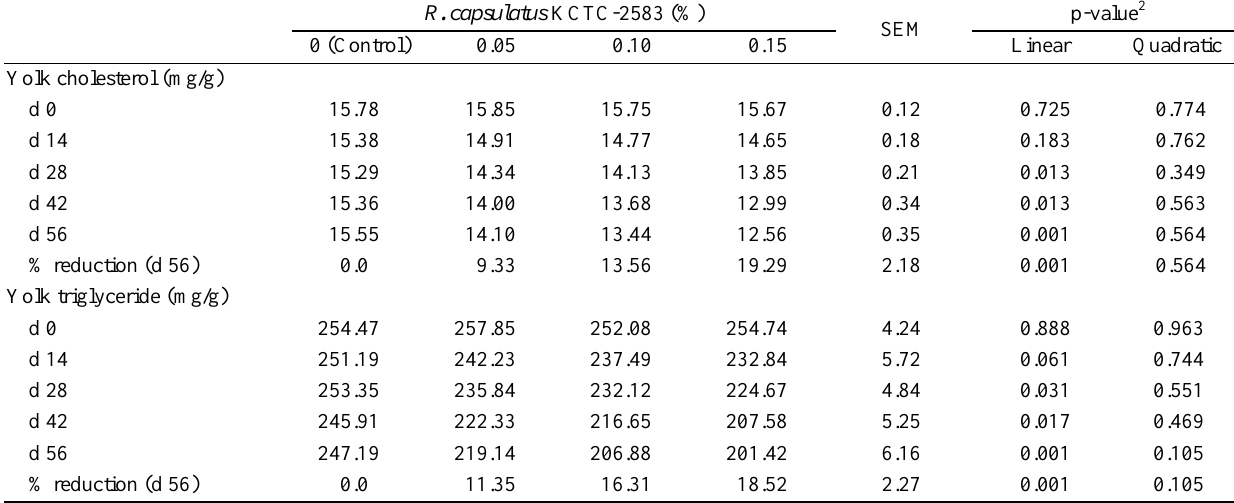
Table 2. Effects of dietary supplementation of Rhodobacter capsulatus KCTC-2583 on egg-yolk cholesterol and triglyceride concentrations in laying hen